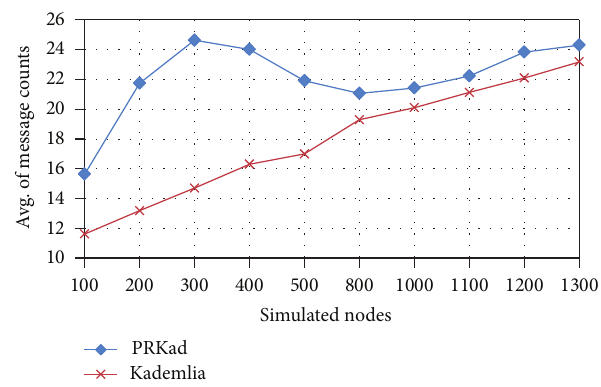
Figure 10: Average of message counts for nodes with successful searches.